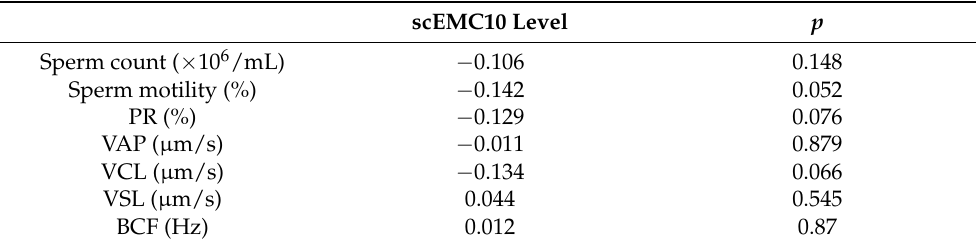
Table 3. Spearman’s correlation analysis between seminal plasma scEMC10 levels and various parameters of sperm motility.